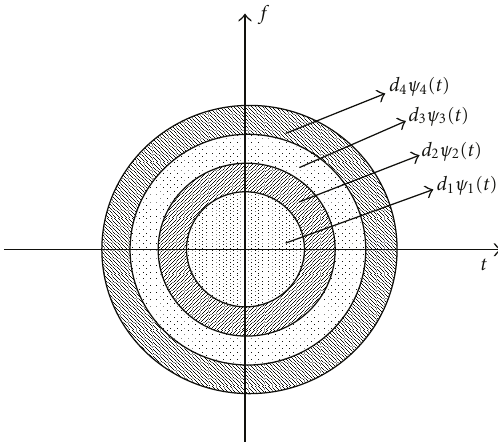
Figure 2: Toroidal-lattice structure model of a baseband transmis- sion